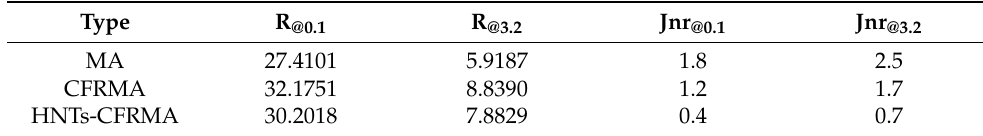
Table 9. Characteristic parameters of asphalt creep